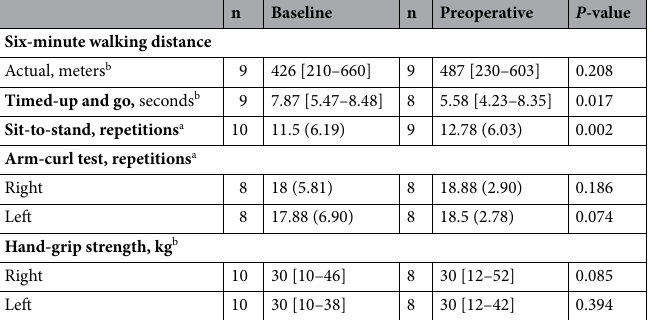
Table 3. Preoperative change in functional capacities. a Mean (standard deviation), b Median [range].